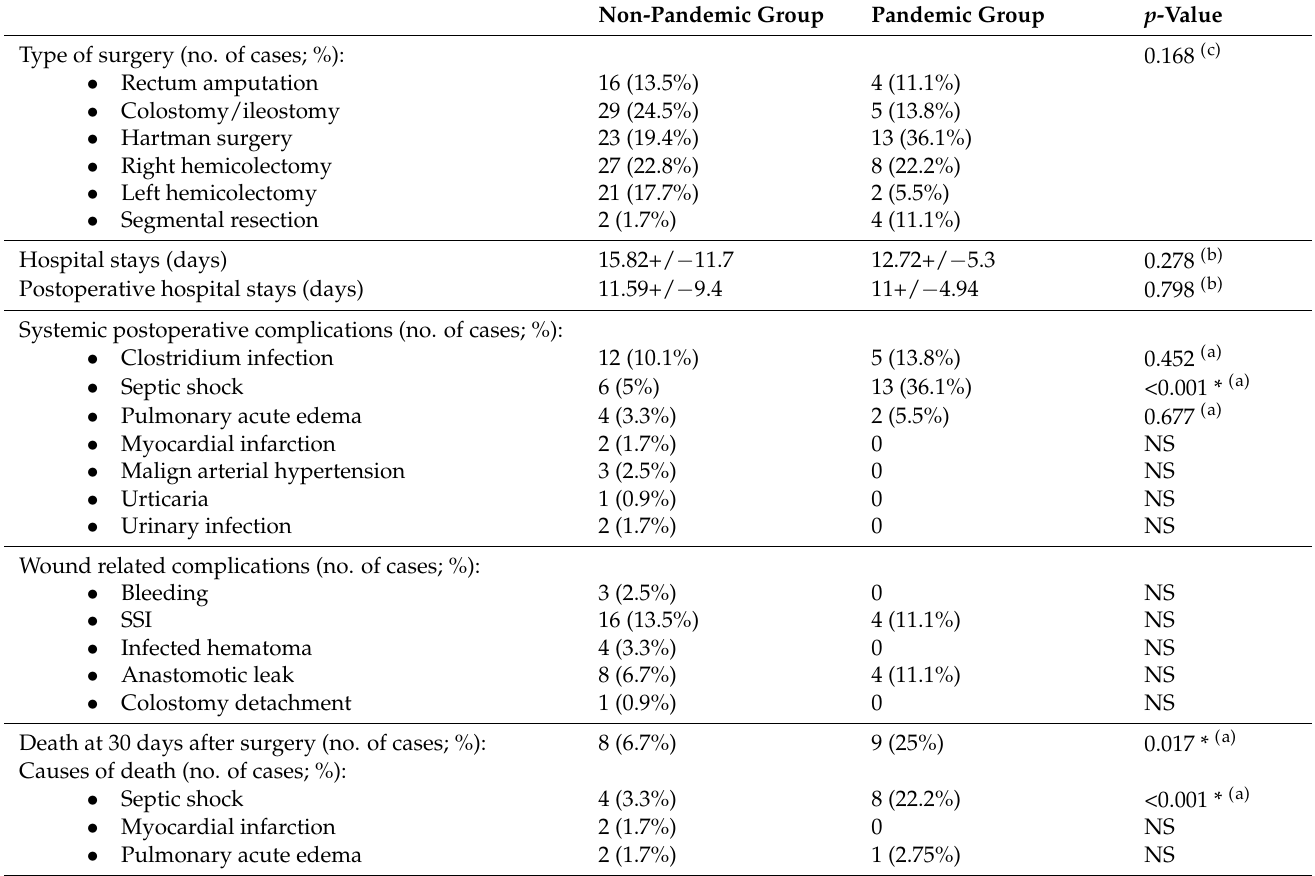
Table 2. Types of surgery, mortality and postoperative complications in the 2 study groups. Non-Pandemic Group Pandemic Group p